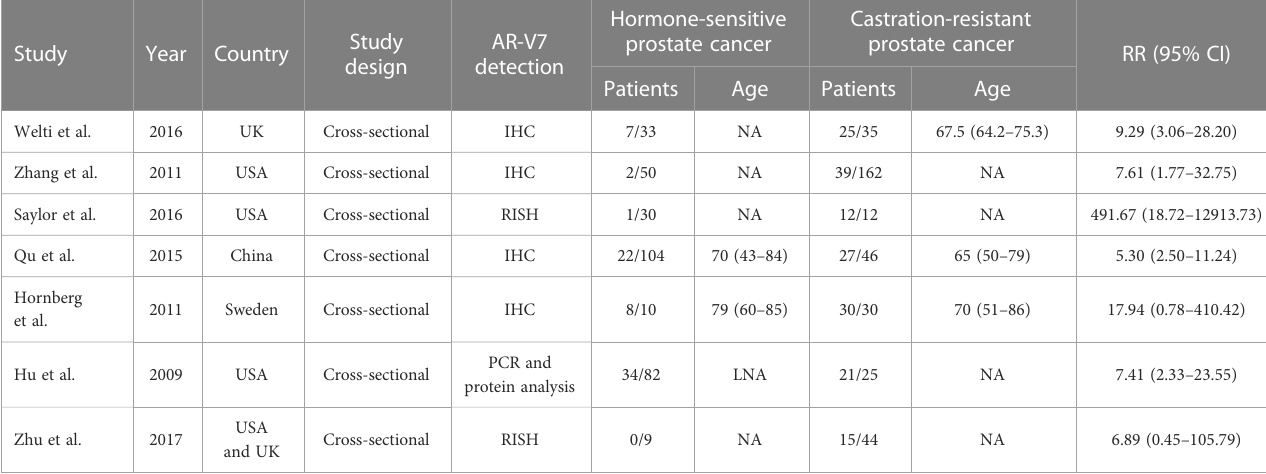
TABLE 1 Characteristics of the included studies in the